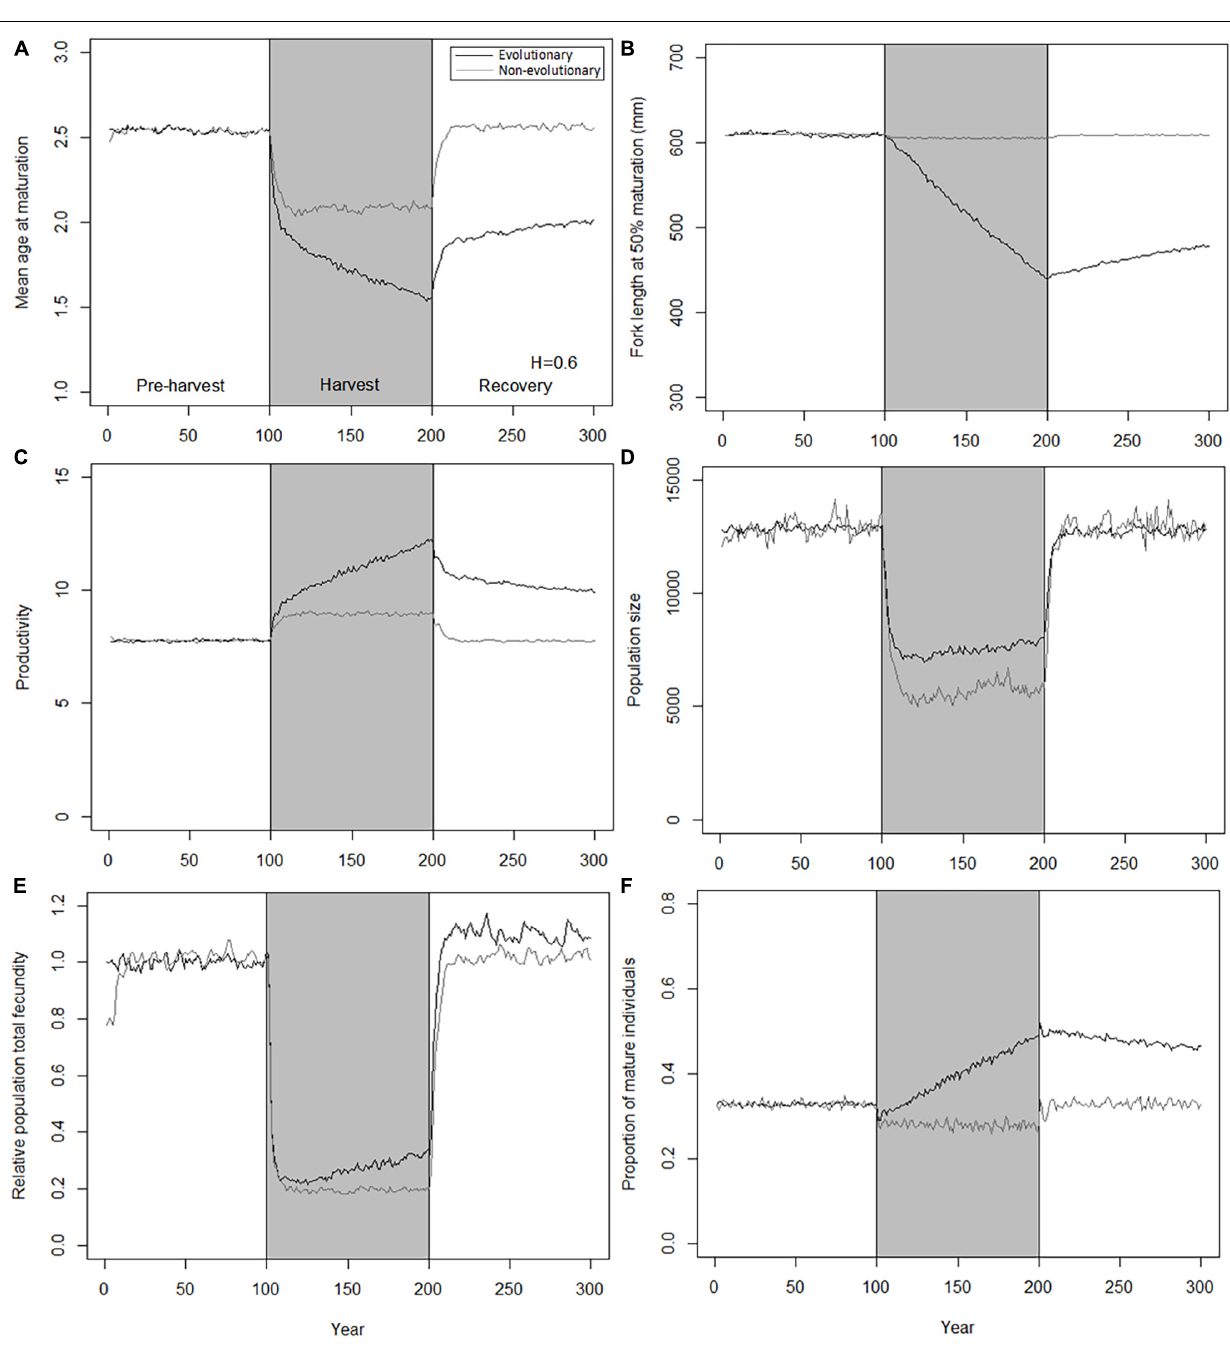
FIGURE 3 | Decrease and subsequent recovery of population traits under 0.6 of instantaneous harvest rate by trawl. Black curves, evolutionary model; gray curves, non-evolutionary model; gray shading, harvest period. (A) Mean age at maturation; (B) fork length at 50% maturation; (C) productivity; (D) population size; (E) relative population total fecundity; (F) proportion of mature